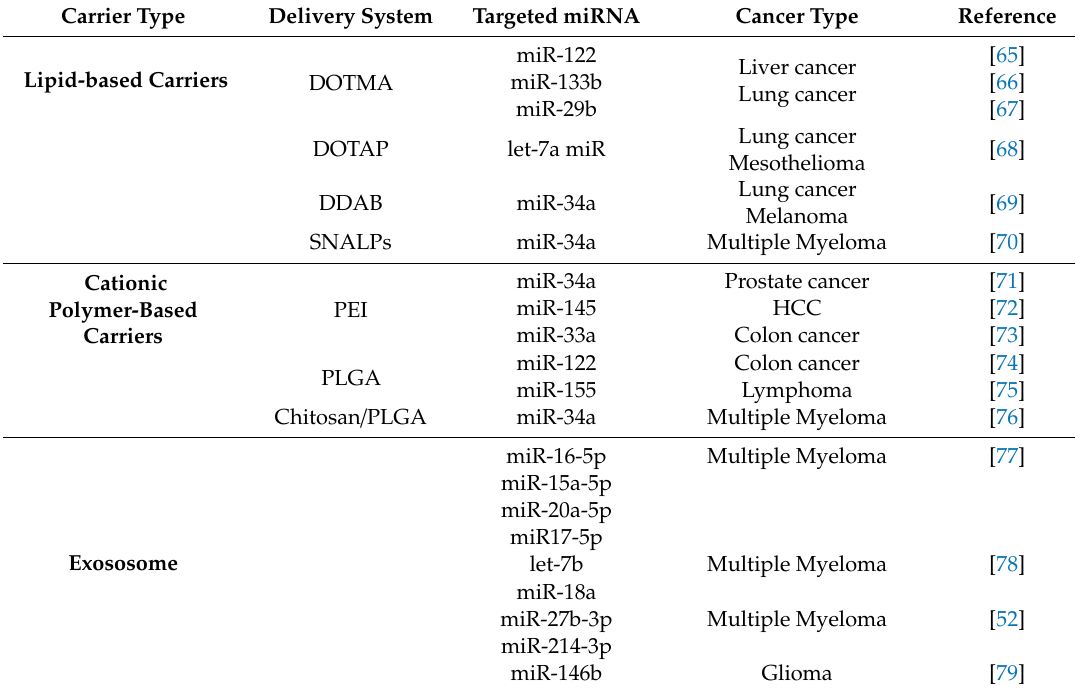
Table 2. Nanocarriers used as therapeutic delivery systems of